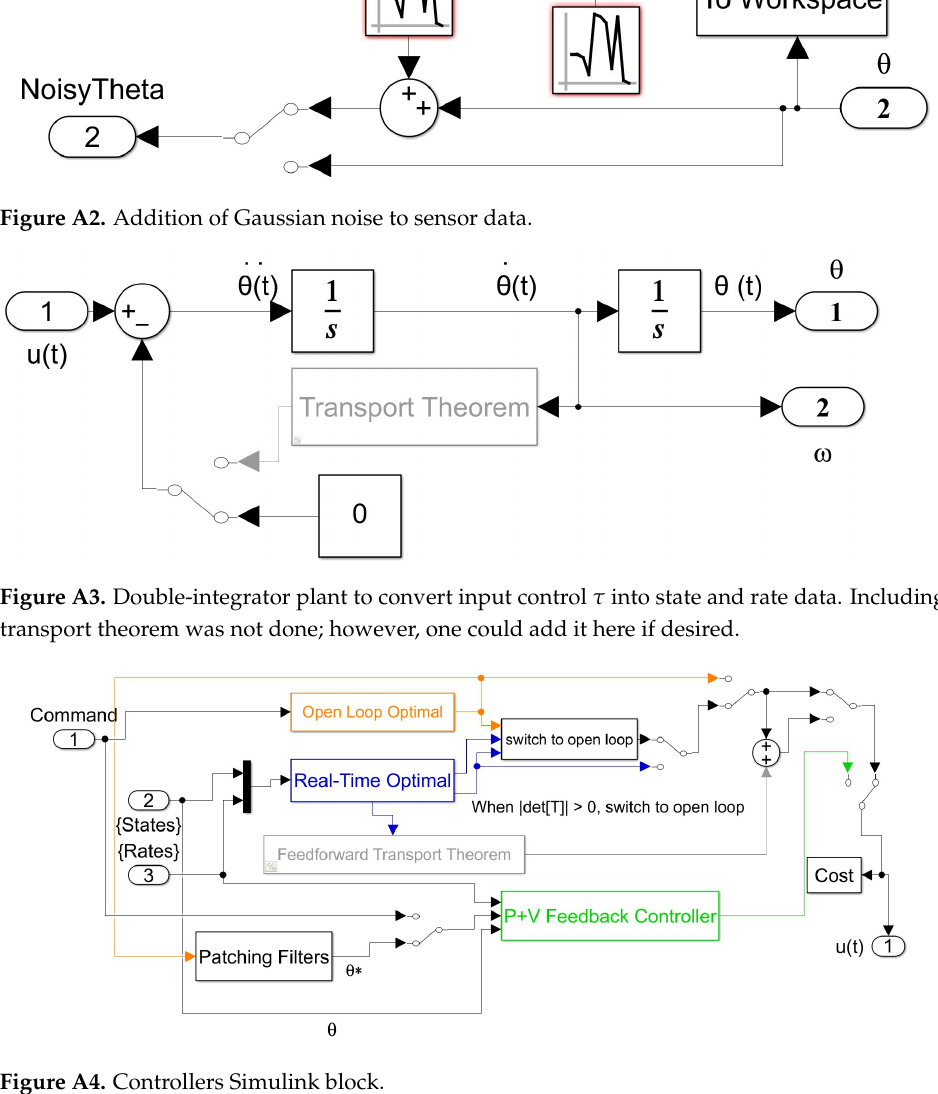
Figure A4. Controllers Simulink